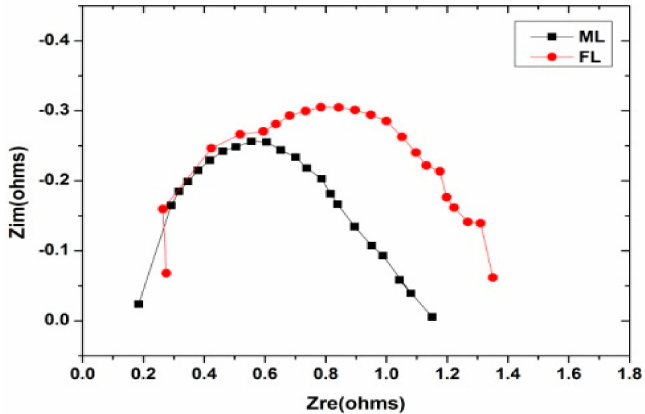
Figure 5. Electrochemical impedance